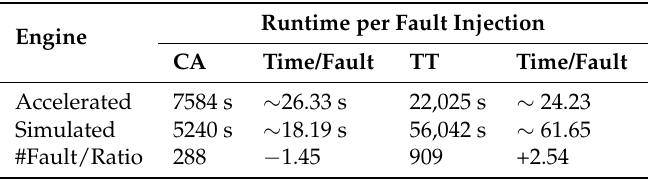
Table 5. Runtime average per fault run when targeting the TT unit.